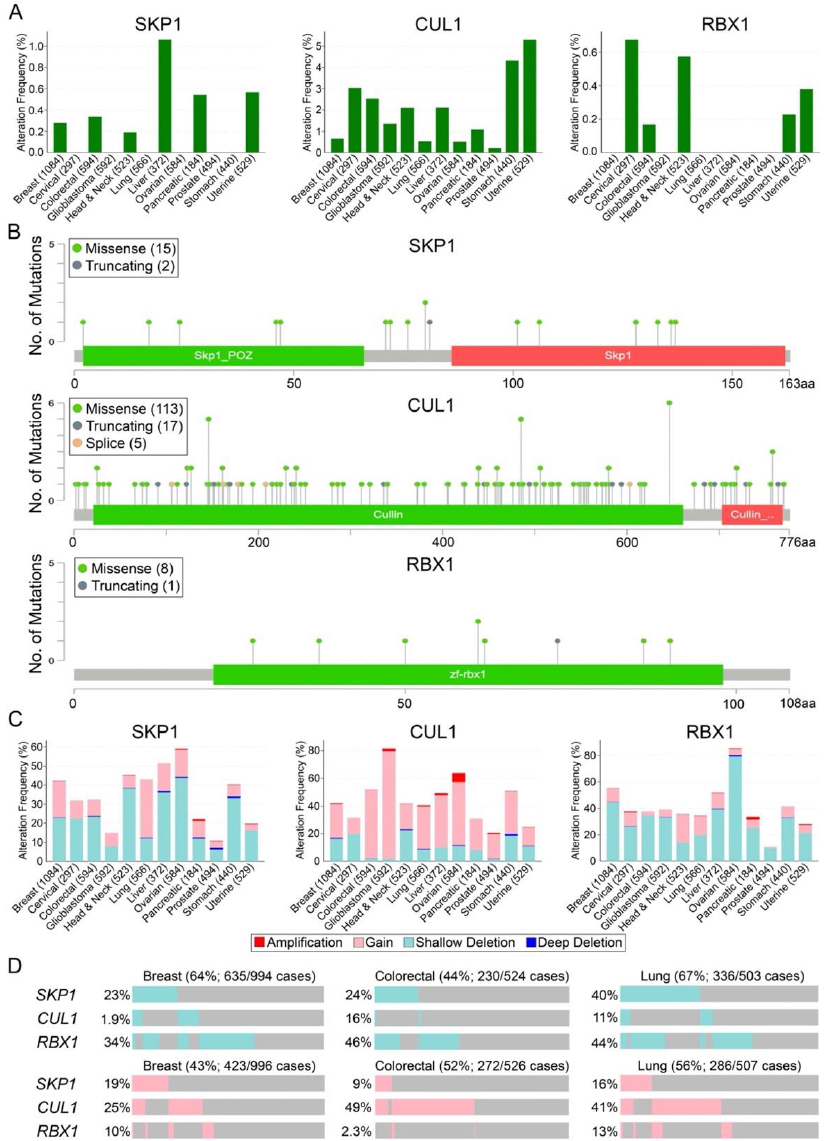
Figure 3. Mutation frequencies of the three core SCF complex members in 12 common cancer types. ( A ) The frequency of total SKP1 (left), CUL1 (middle) and RBX1 (right) mutations, including missense, truncating, inframe, and fusions in 12 common cancer types (total cases) assessed using TCGA pan- cancer atlas data [58]. Note that missense and truncating mutations were identified for all three genes, while CUL1 also harbors splice mutations. ( B ) Schematics from cBioPortal [56,57] mapping the protein positions of the corresponding mutations in SKP1 (top), CUL1 (middle), and RBX1 (bottom). Note that, in general, the distribution of the encoded mutations is spread across the entirety of each protein in agreement with a tumor suppressor mutational load. ( C ) Prevalence of SKP1 (left), CUL1 (middle), and RBX1 (right) copy number alterations including deep deletions, shallow deletions, gains, and amplifications in 12 common cancer types (total cases) [56–58]. Note that, in general, SKP1 and RBX1 exhibit more frequent copy number losses, whereas CUL1 generally exhibits more gains. ( D ) Oncoprint data for breast, colorectal, and lung cancers depicting the individual and cumulative frequencies of SKP1 , CUL1 , and RBX1 shallow deletions (top) or copy number gains (bottom) [58]. Vertical alignments within either the shallow deletions or gains categories identify samples from the same patient; patient-specific comparisons cannot be made between